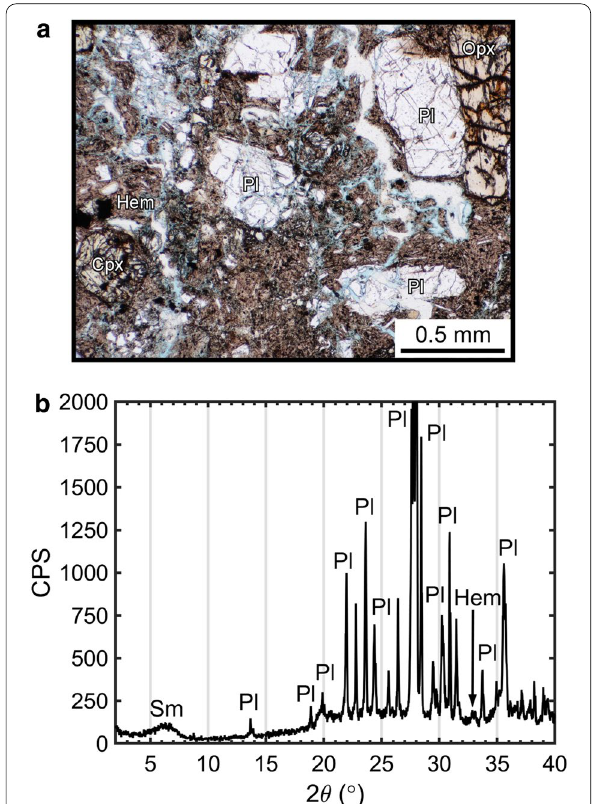
Fig. 2 Porous tuff breccia sample used in the experiments.